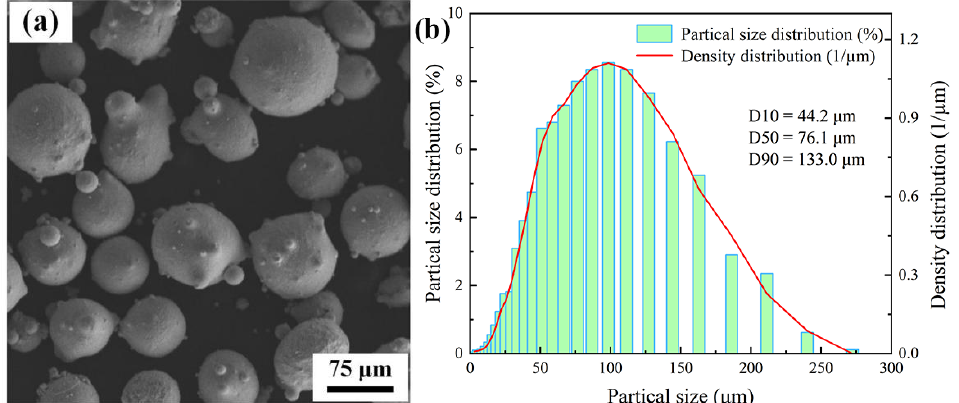
Figure 1. Pre-alloyed Al 0.5 FeCoCrNi HEA powder: ( a ) SEM image of microscopic morphology; ( b ) Particle size distribution and density distribution. Table 1. Chemical composition of 316 stainless steel (wt.%).